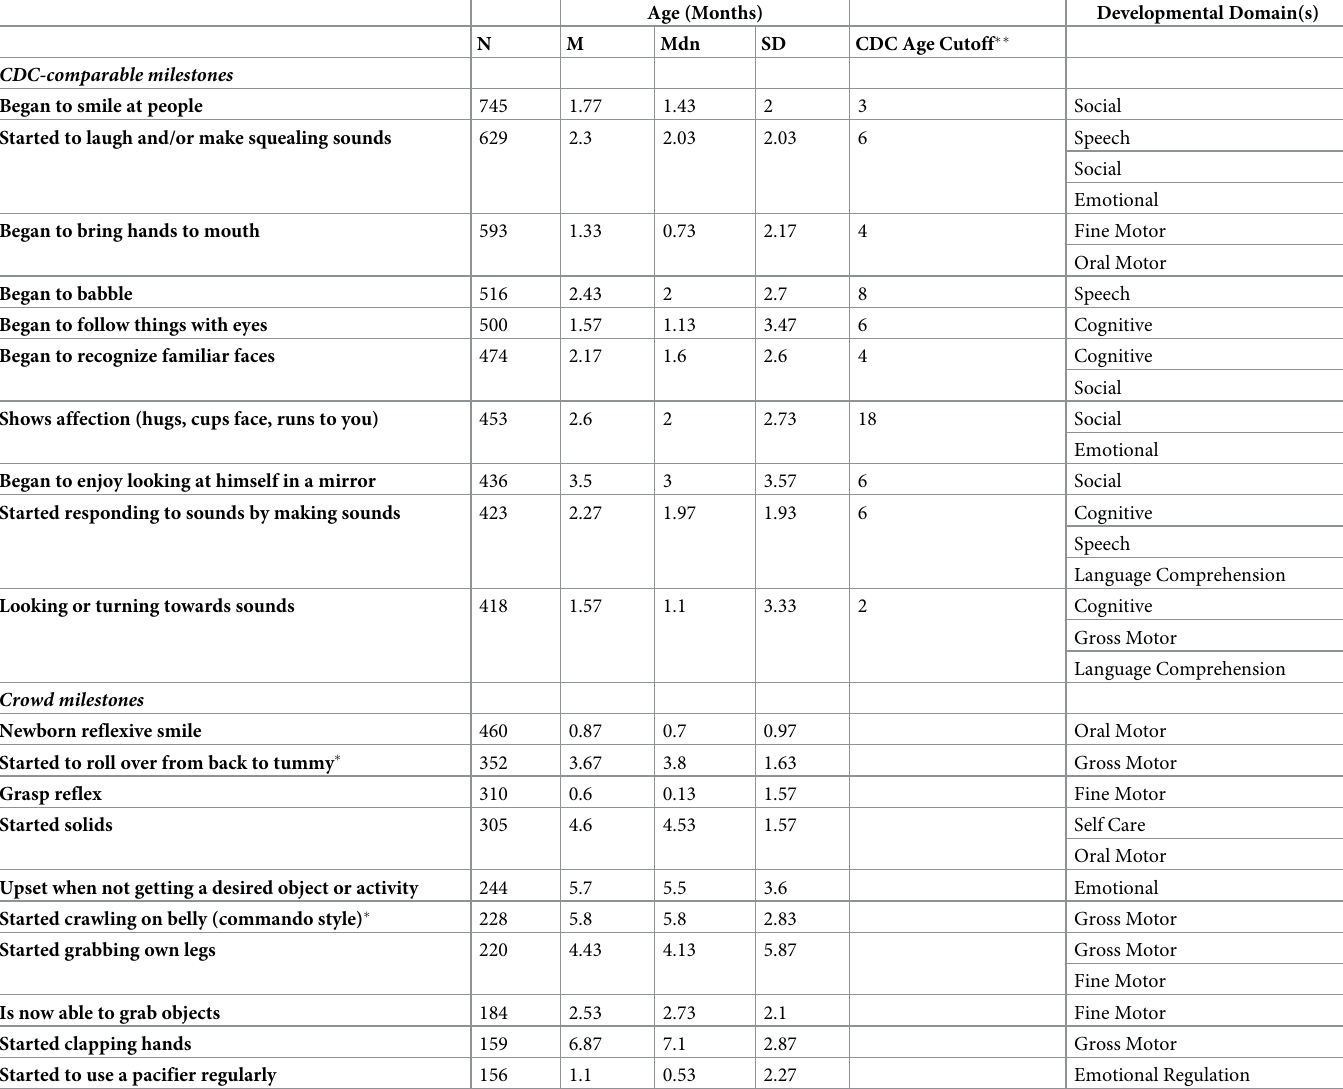
Table 1. Characteristics of the top 10 CDC milestones and top 10 crowd milestones in the